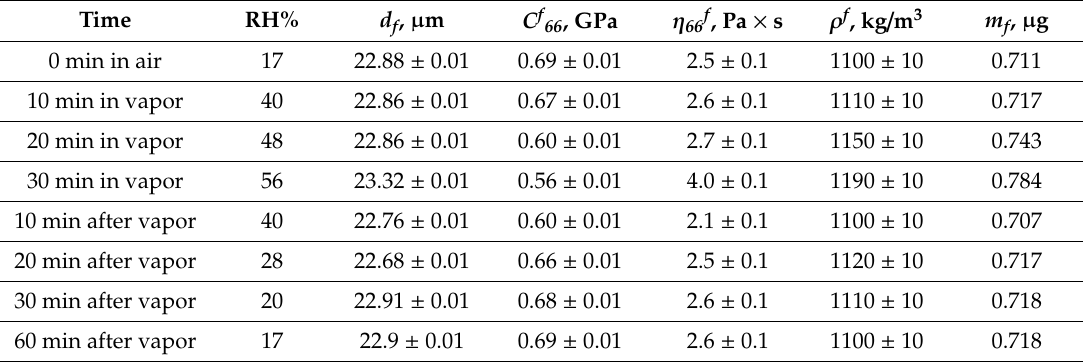
Table 2. Parameters of the mushroom P. eryngii mycelium film at di ff erent values of humidity.